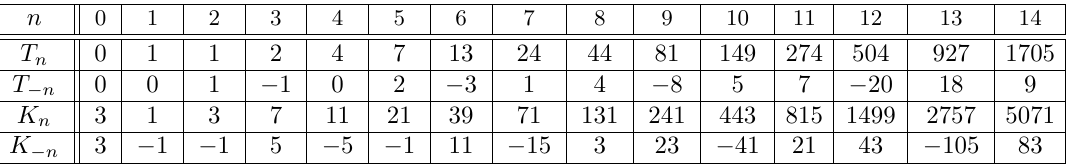
Table 1: Tribonacci and tribonacci–Lucas